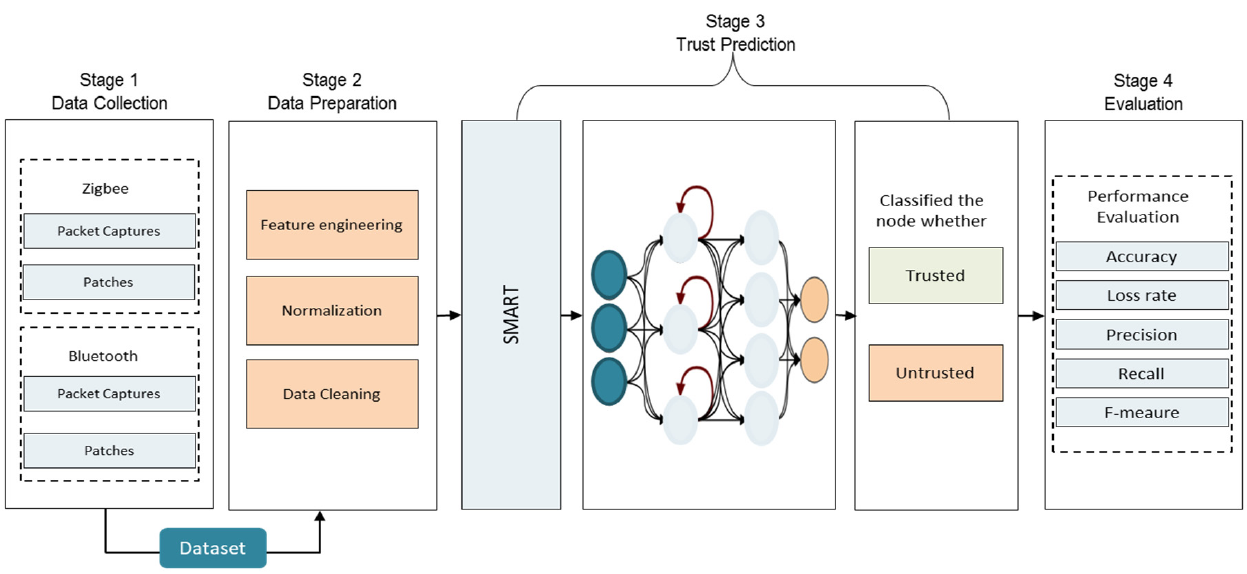
Figure 3. Proposed Model.